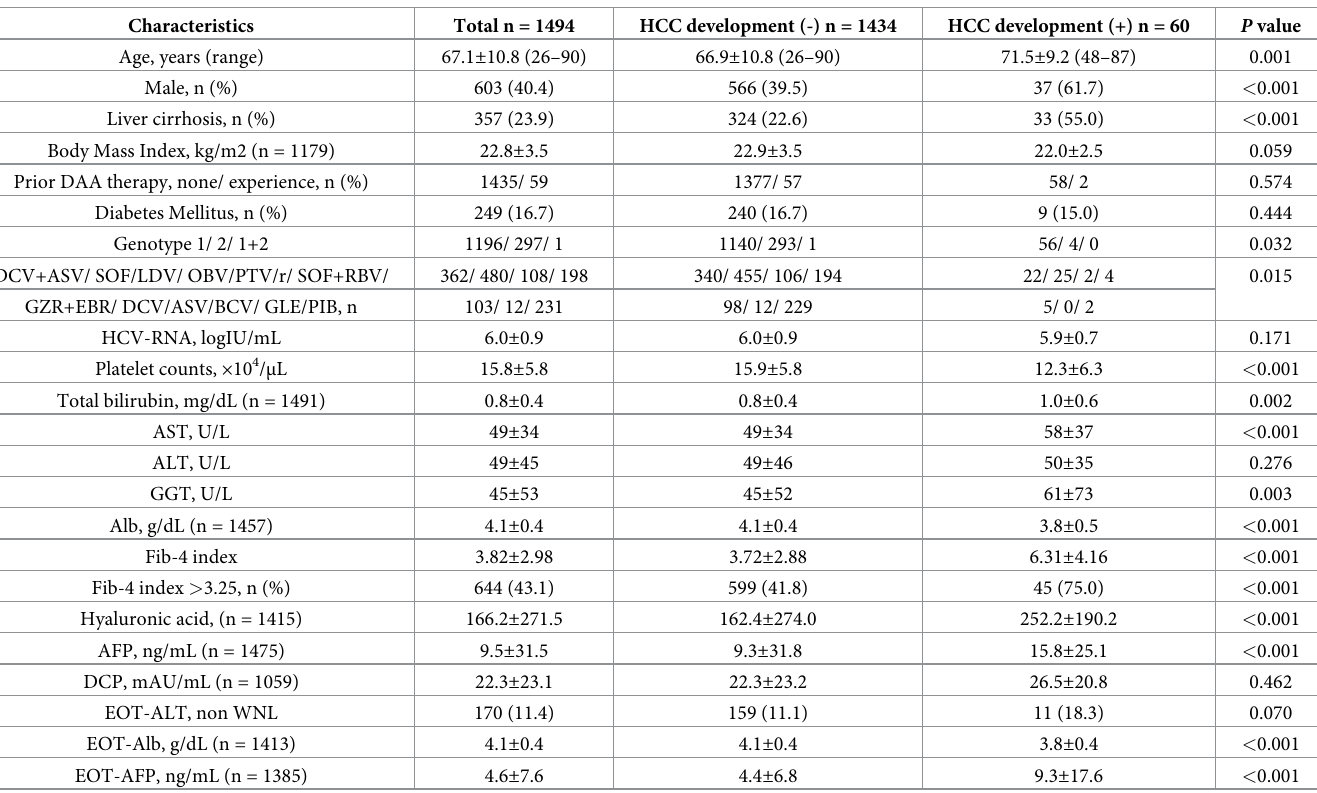
Table 1. Patient